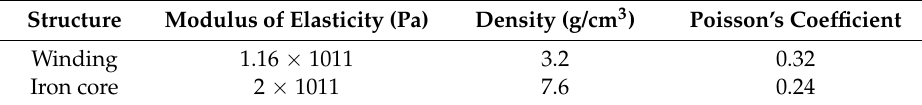
Table 4. The main material properties of the solid mechanics model.